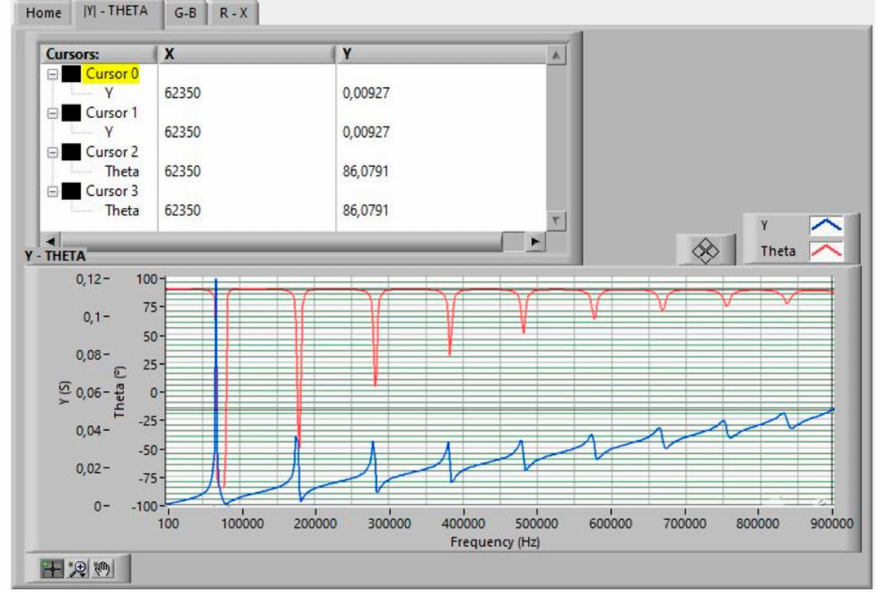
Figure 10. Sweep frequency data measurement results.